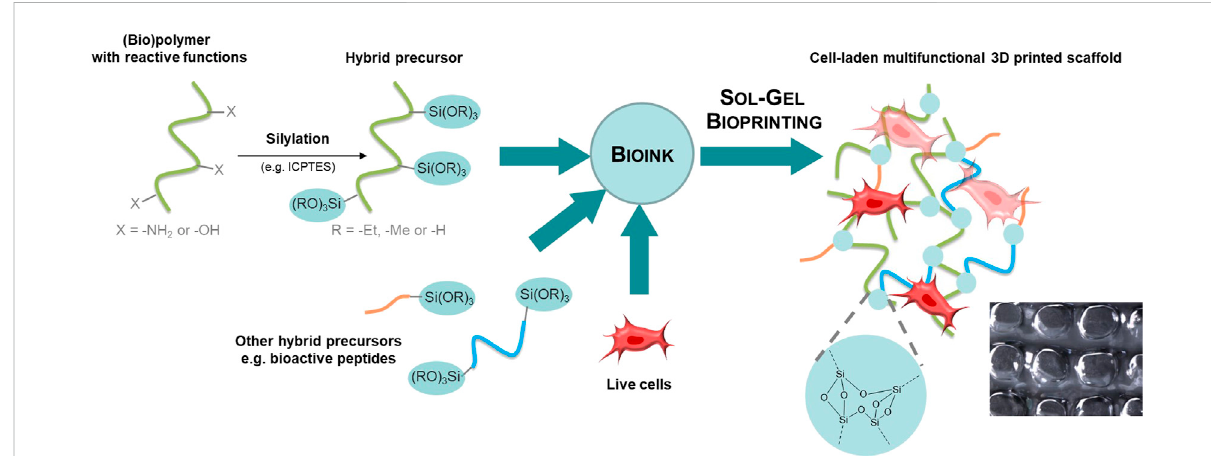
FIGURE 1 The sol-gel chemistry applied to bioprinting. Hybrid precursors are obtained by functionalization of synthetic or natural polymers, peptides or small organic molecules with alkoxysilane groups using a silylation reagent such as the isocyanatopropyltriethoxysilane (ICPTES). Hybrid precursors and live cells are mixed together in the desired ratio to provide the bioink. The sol-gel process occurs during extrusion-based bioprinting. The 3D printed scaffold encapsulates cells into a covalent organic-inorganic 3D network.